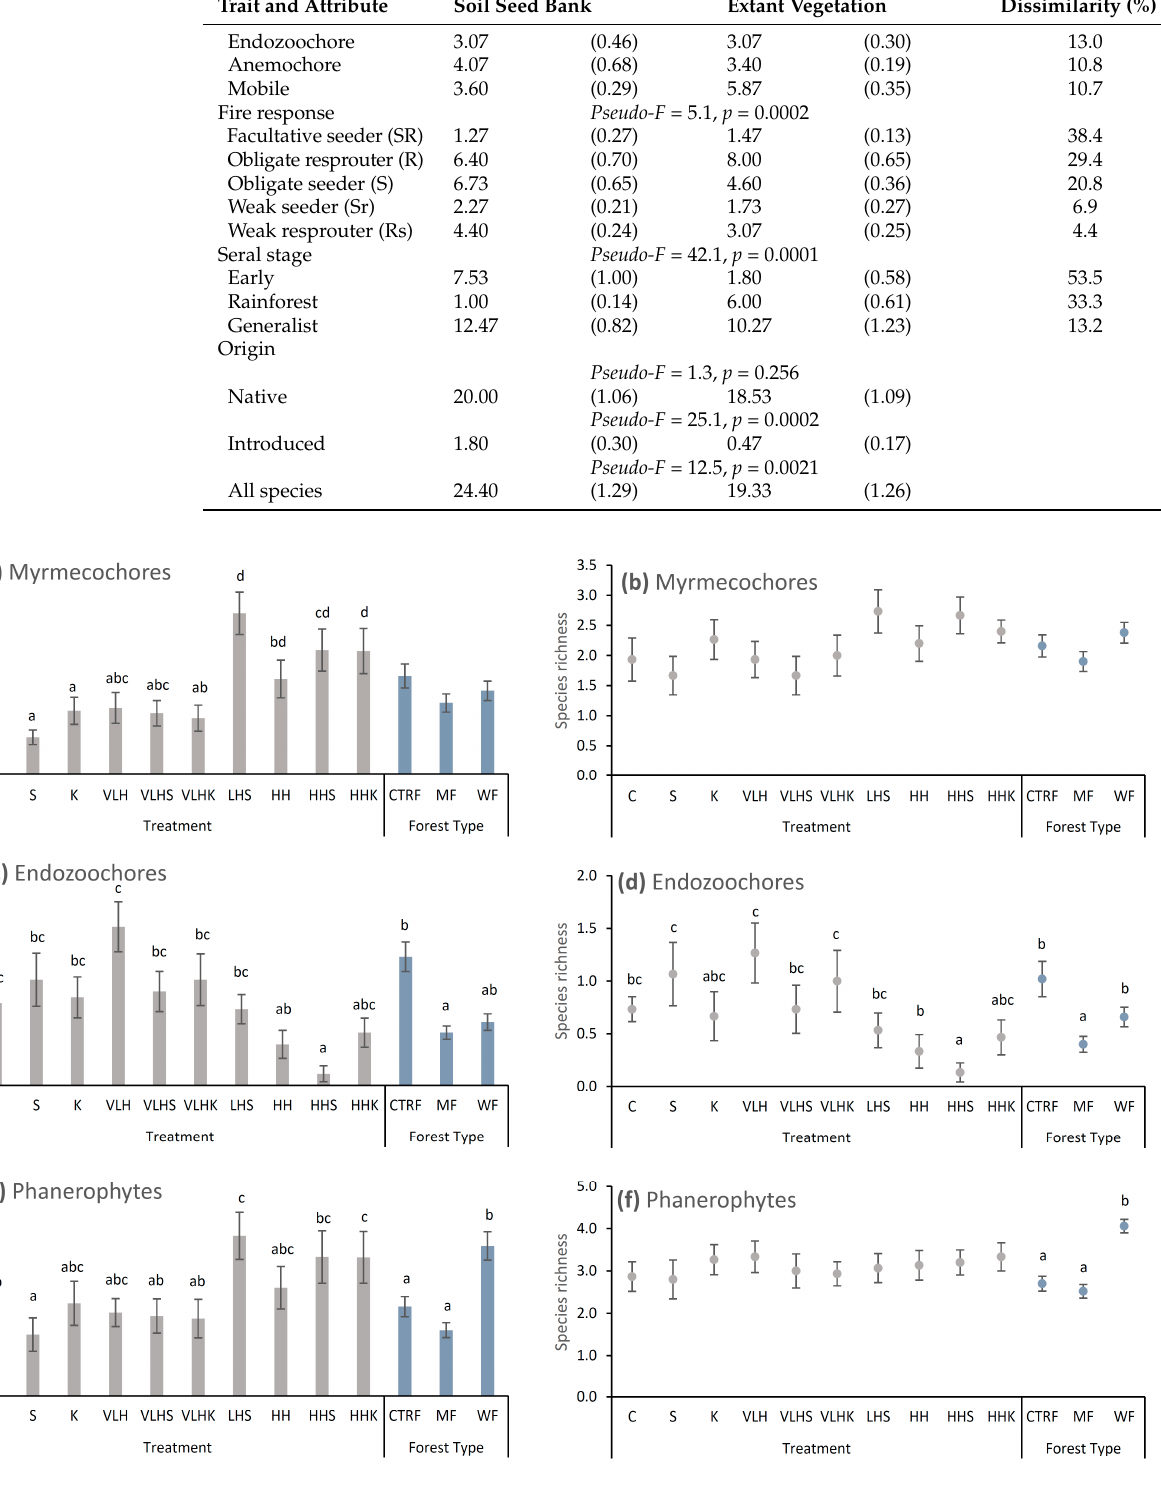
Figure 2. Soil seed bank treatment (see Table 1) and forest type (CTRF, cool temperate rainforest; MF, mixed forest; WF, wet forest) e ff ects on germinant density (bars) and richness (circles) (mean per site, standard error) of: ( a , b ) myrmecochores, ( c , d ) endozoochores, ( e , f ) phanerophytes, and ( g , h ) therophytes. Signi fi cant pairwise comparisons ( p ≤ 0.05) within treatments or forest type are indicated by di ff erent le tt ers. There were no signi fi cant interaction e ff ects. Soil seed bank treatment e ff ects were not signi fi cant for other functional a tt ributes with model results provided in Table S5. There were no signi fi cant di ff erences in functional trait associations among soil seed bank treatments ( Pseudo-F = 1.0, p = 0.3744). Trait associations did however di ff er among forest types ( Pseudo-F = 7.8, p = 0.0001) with no signi fi cant interactions (Table S6). Trait associations di ff ered among all forest types with increased abundance of rainforest seral a ffi liation, mobile and obligate resprouters in CTRF relative to MF and WF, and greater abundance of anemochores in WF relative to other forest types (SIMPER, Table S7, Figure S5).